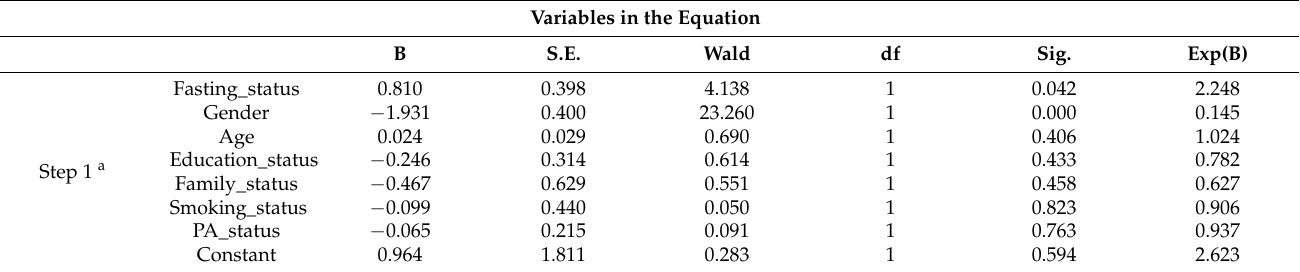
Table 5. Logistic regression analysis results for blood